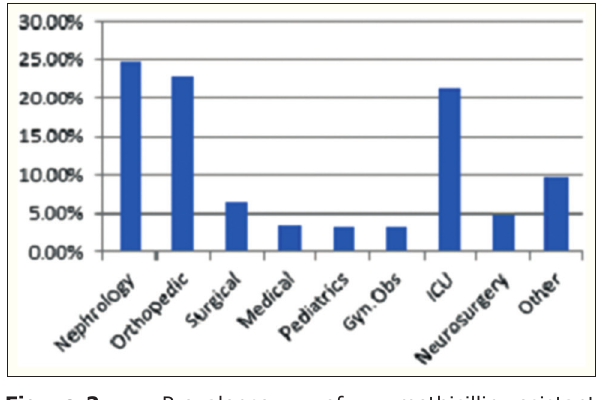
Figure-2: Prevalence of methicillin-resistant Staphylococcus aureus bacteremia according to unit of patient’s